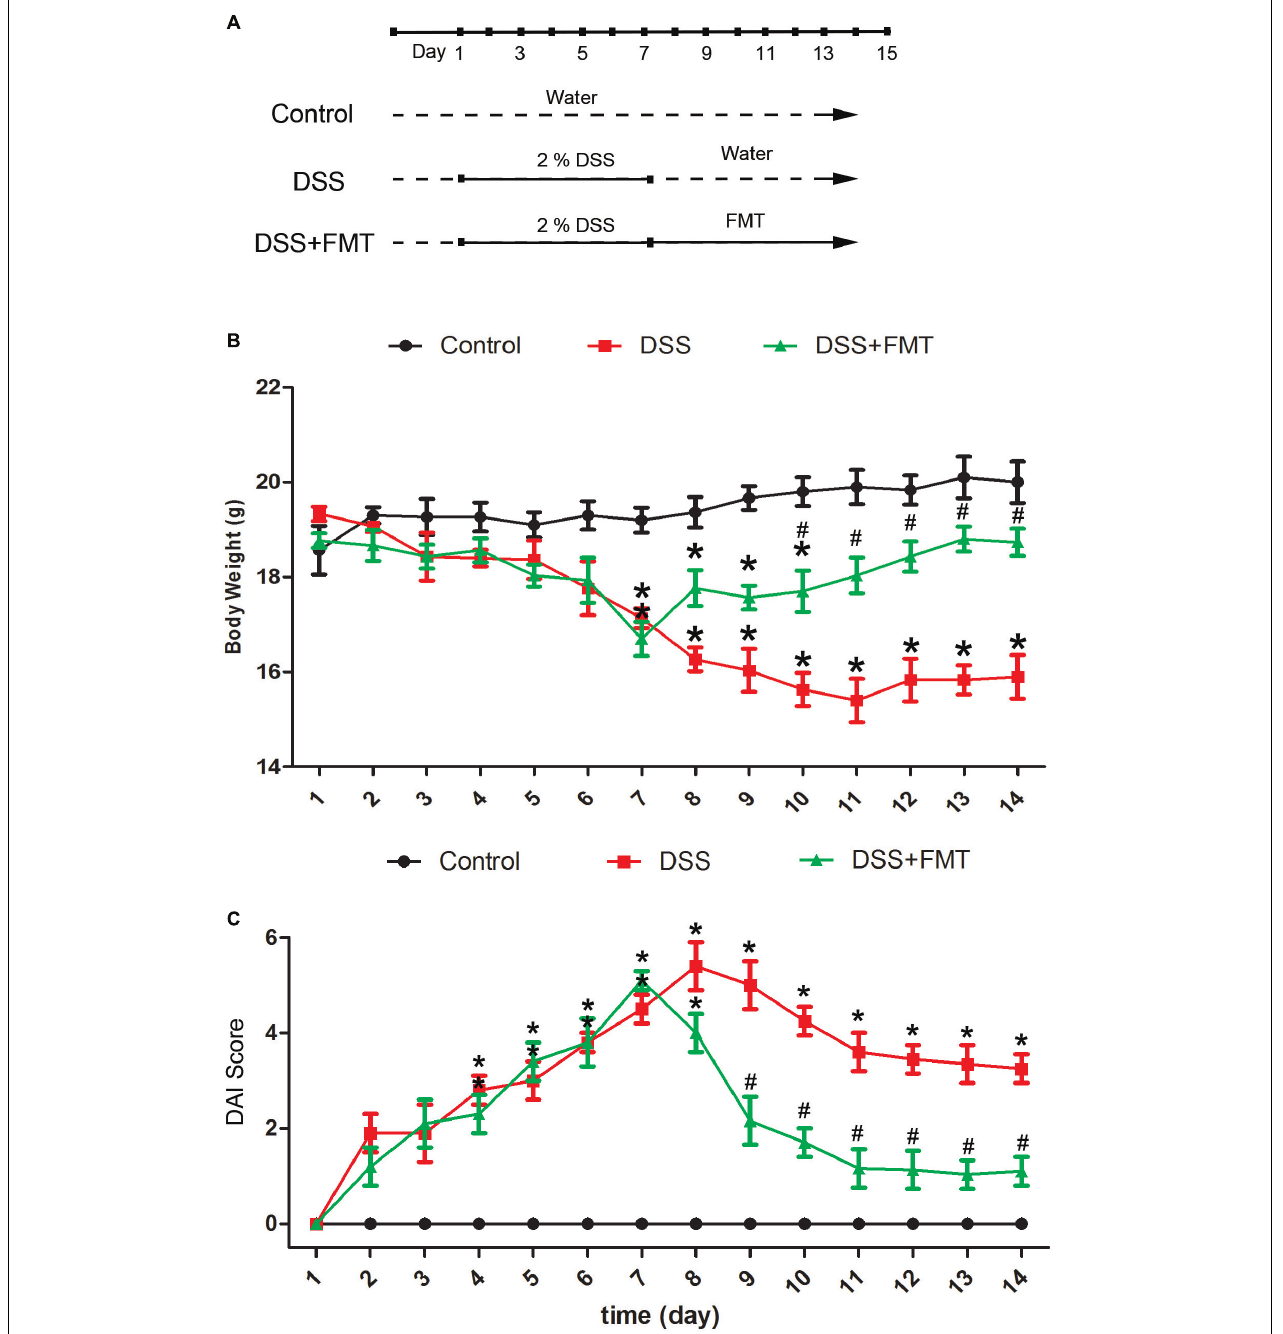
FIGURE 1 | Fecal microbiota transplantation reversed body weight loss and decreased the Disease Activity Index (DAI) score of mice with acute colitis induced by DSS. (A) Experimental protocol. (B) Average body weight at the indicated time point in each group. (C) Several clinical indexes of disease, including weight loss, stool consistency, occult blood positivity, and gross rectal bleeding, were monitored to calculate a cumulative DAI score. DAI scores were recorded at the indicated time point in each mouse. Data are shown as the mean ± SD ( n = 3 mice per group) of triplicate experiments. ∗ p < 0.05 compared to the control group. # p < 0.05 compared to the DSS